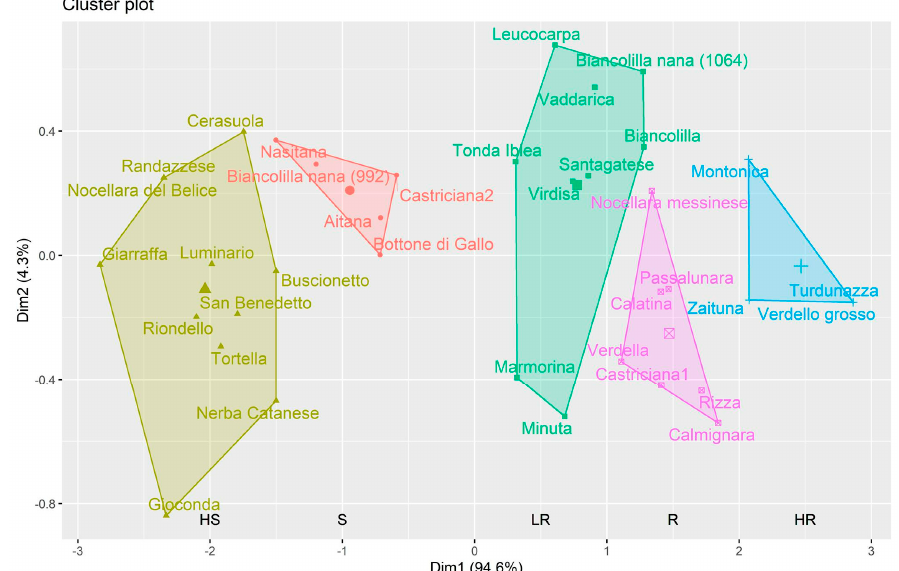
Figure 2. Cluster graph produced according to the disease intensity of 36 cultivars calculated as the mean of the 3-year assessment, revealing the presence of 5 clusters. HS: highly susceptible, S: susceptible, LR: low resistant, R: resistant, and HR: highly